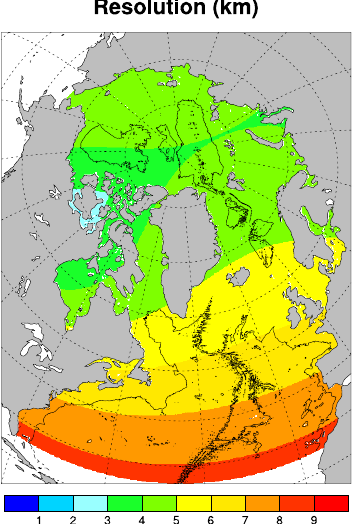
Figure 1. CREG12 domain and horizontal resolution (in kilome- tres). The 3000m contour of the modelled bathymetry is